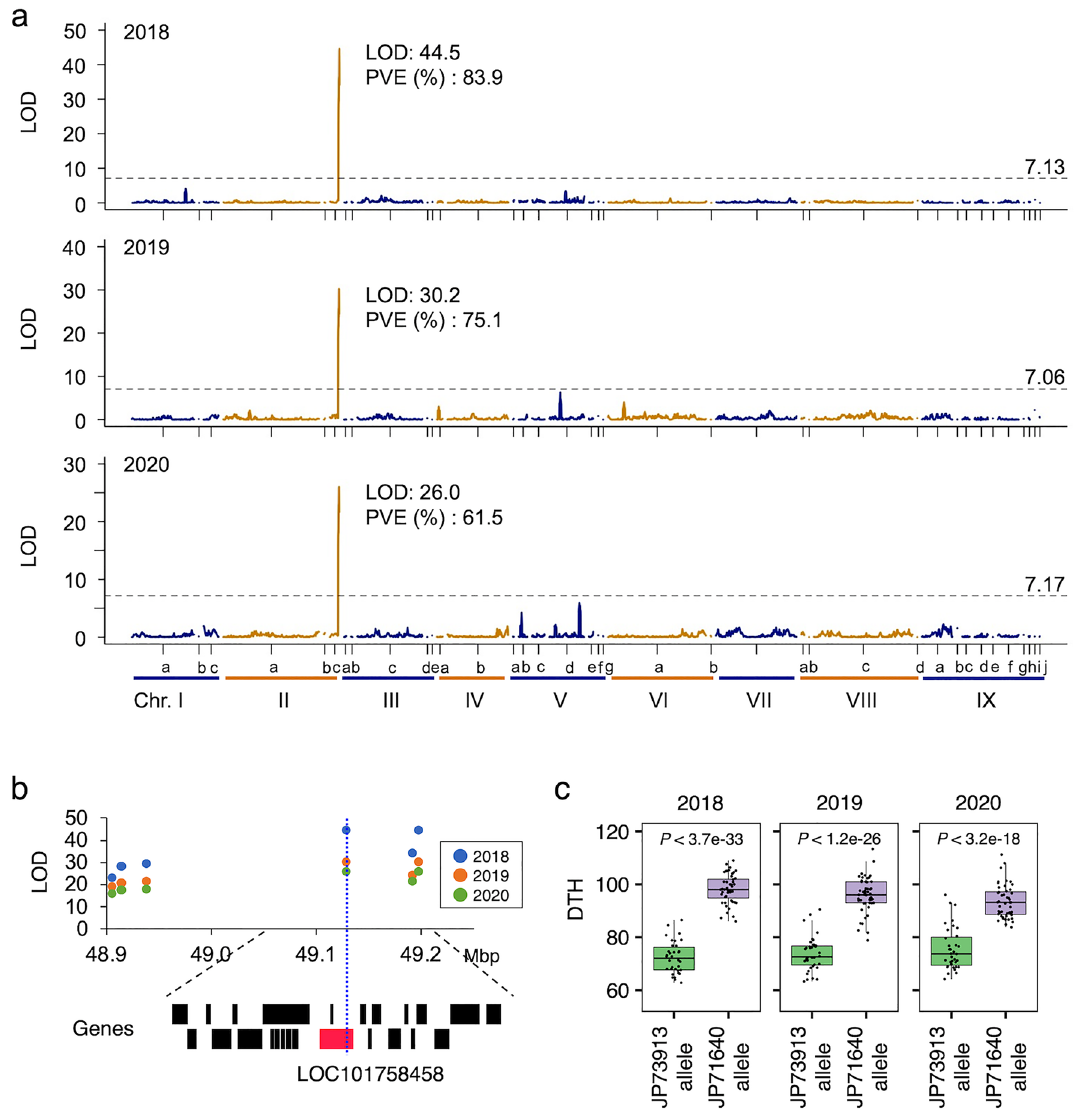
Figure 6. Analysis of days to heading (DTH) in foxtail millet. ( a ) Distribution of LOD scores for RILs in three years. PVE indicates the phenotypic variation explained by QTL. ( b ) Enlarged view of the physical map around the QTL. The annotated genes on the S. italica reference genome are shown at the bottom part, and the red one is SiPRR37 which is the candidate gene for DTH. ( c ) Box and dot plots of DTH between the different genotypes (JP73913 homozygous allele and JP71640 homozygous allele) at the marker on SiPRR37 . P -values obtained by the student’s two-sample t-test function in R are shown in each panel to assess statistical significance between the two genotypes of the